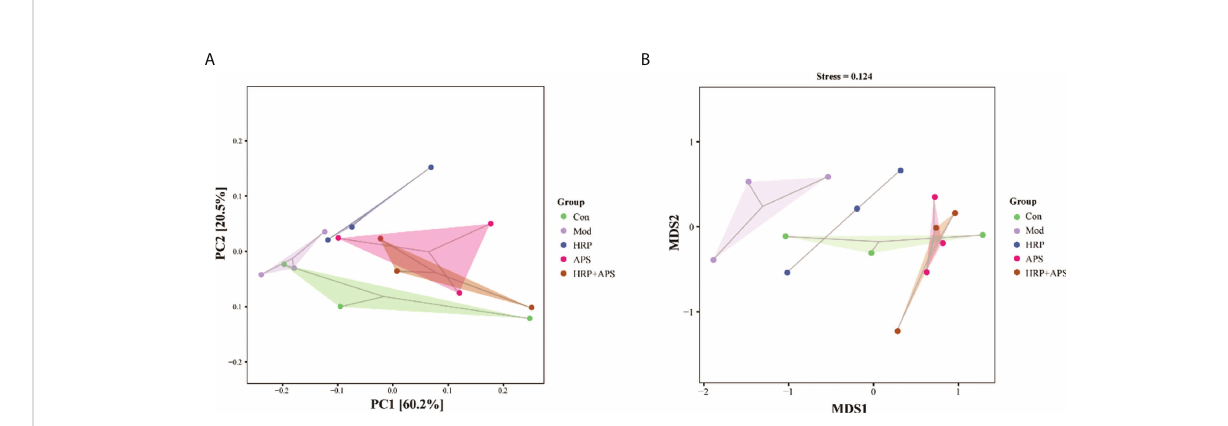
FIGURE 5 Effect of HRP, APS and the combination of HRP and APS on the beta diversity of mice intestinal mucosal bacteria. (A) PCA and (B)